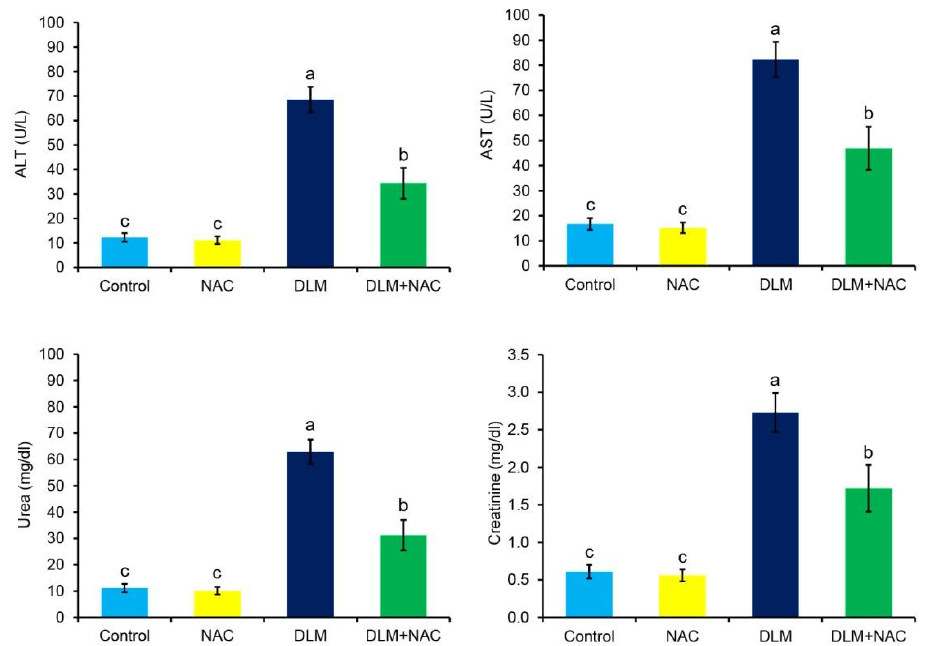
Figure 2. Effect of DLM and/or NAC treatments on the hepato-renal function. The values are expressed using the mean ± SE ( n = 3). The statistically significant difference ( p ≤ 0.05) is indicated by different superscript characters.